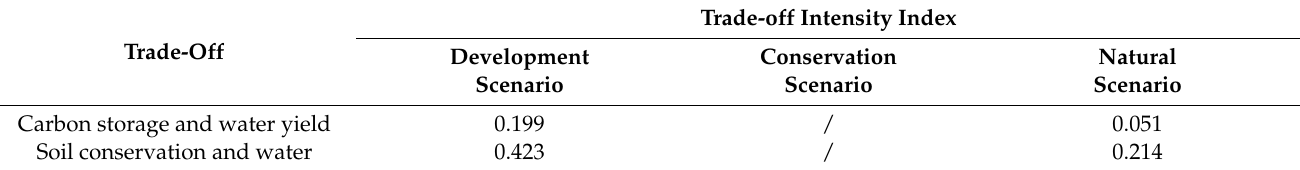
Table 6. Strength of the trade-off between ecosystem services under different